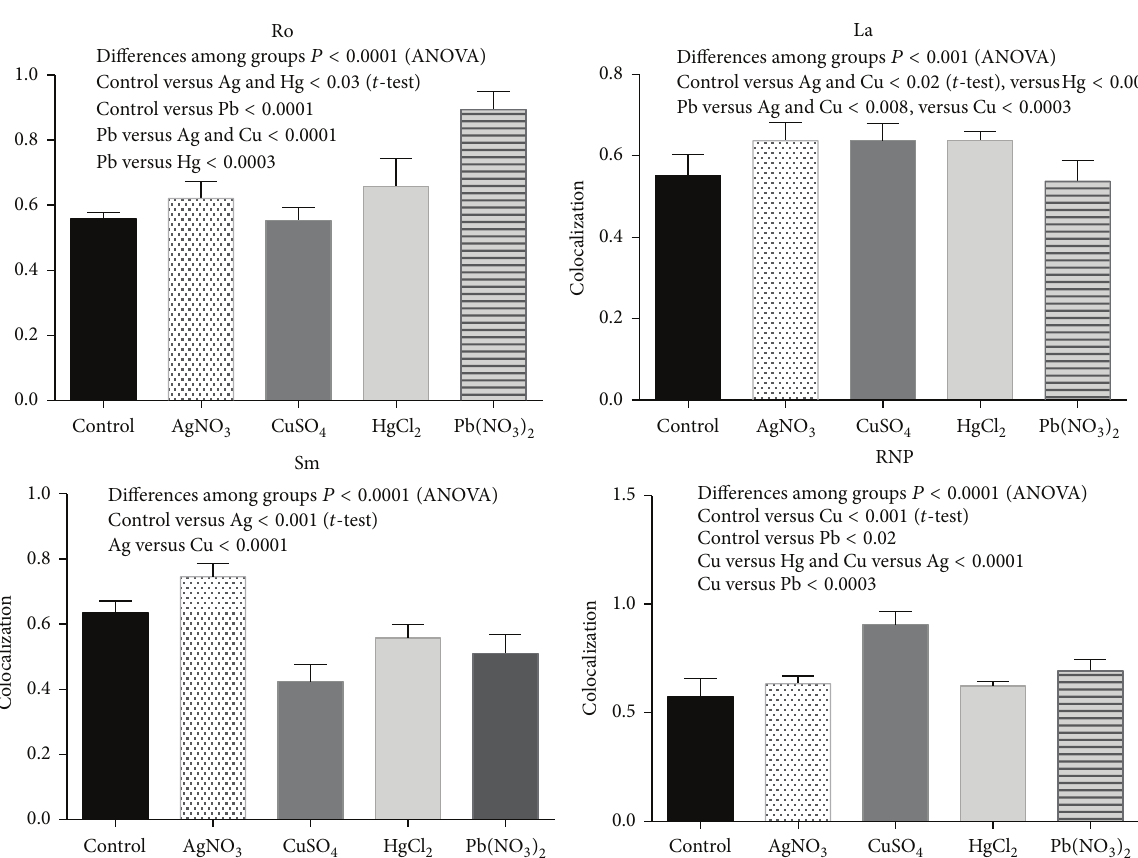
Figure 9: Colocalization analysis graphs (mean and SD) of ribonucleoproteins and apoptotic membranes (annexin) induced by heavy metal salts.